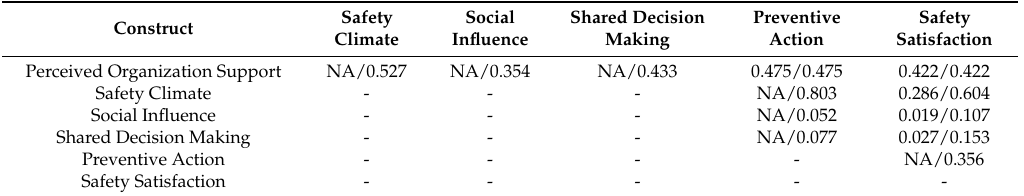
Table 5. Results of standardized indirect and total effects